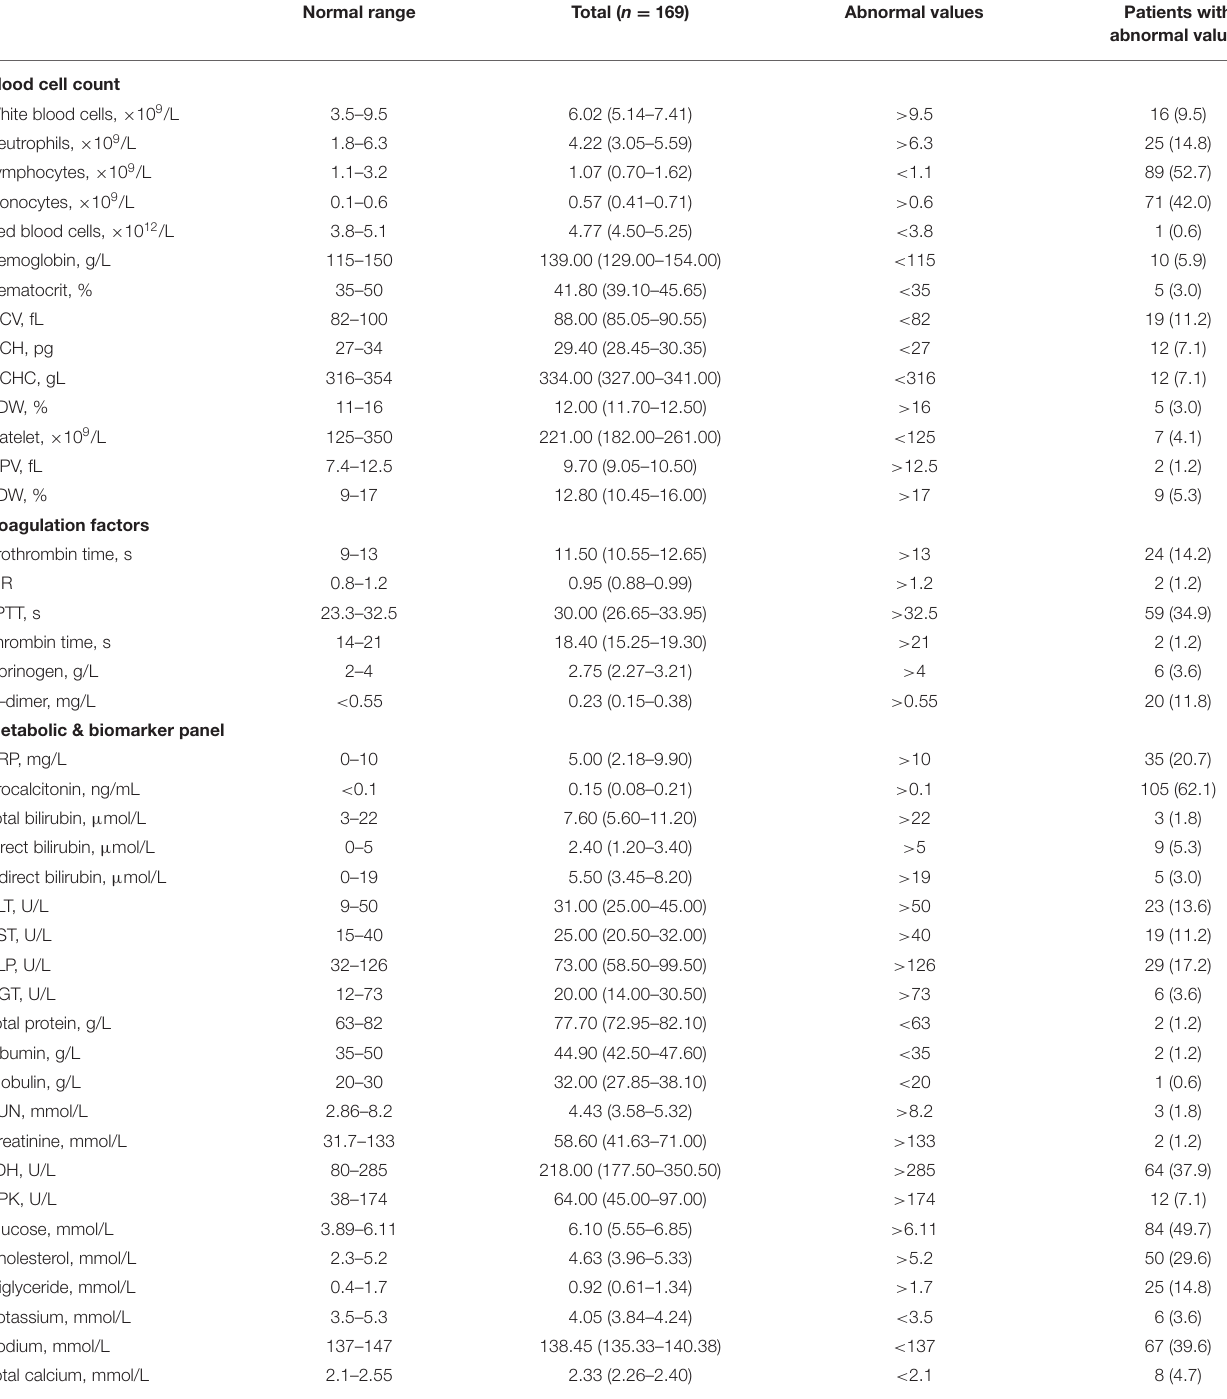
TABLE 2 | Baseline characteristics of COVID-19 patients infected by the omicron variant in their hematological profiles. Normal range Total ( n = 169) Abnormal values Patients with